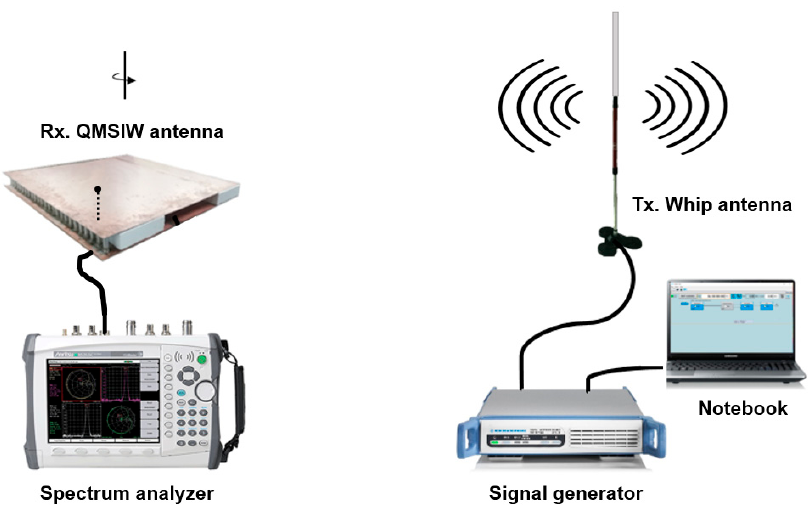
Figure 11. Measurement setup for fabricated antenna’s received power.